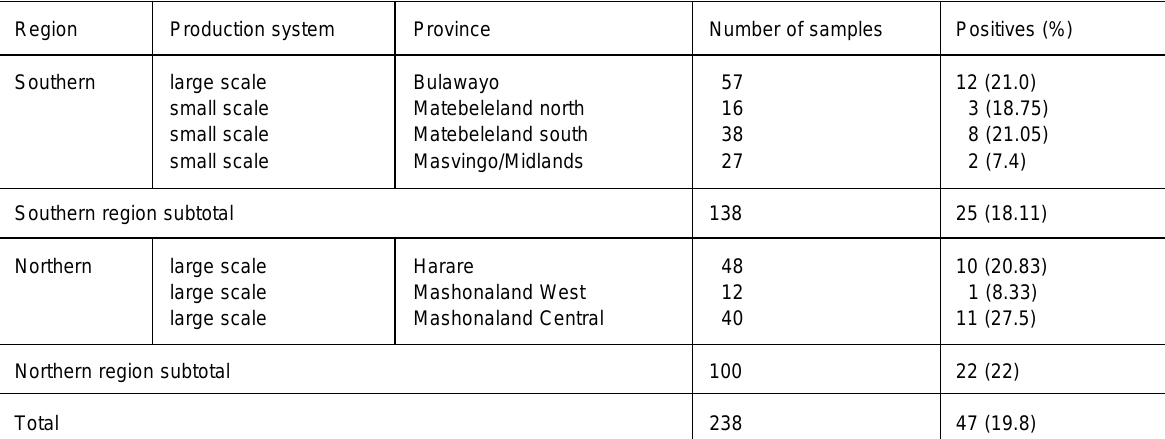
TABLE 1 Prevalence of anti- Toxoplasma gondii IFAT IgG antibodies in fattening pigs from commercial farms